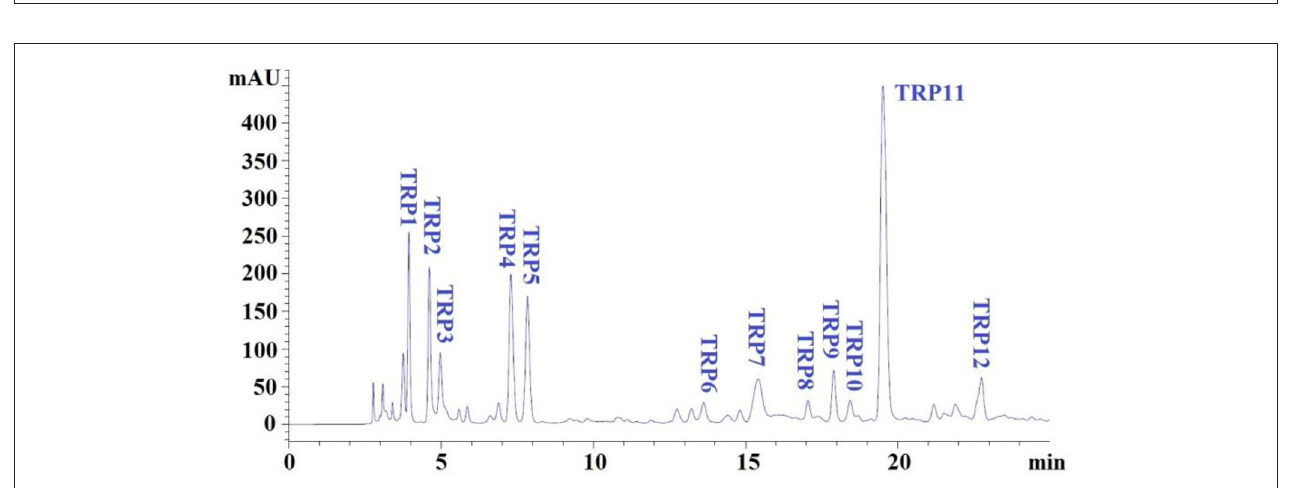
FIGURE 5 | Elution profiles of subfraction IC-ii by RP-HPLC using a gradient of acetonitrile containing 0.05% trifluoroacetic acid at 280nm.